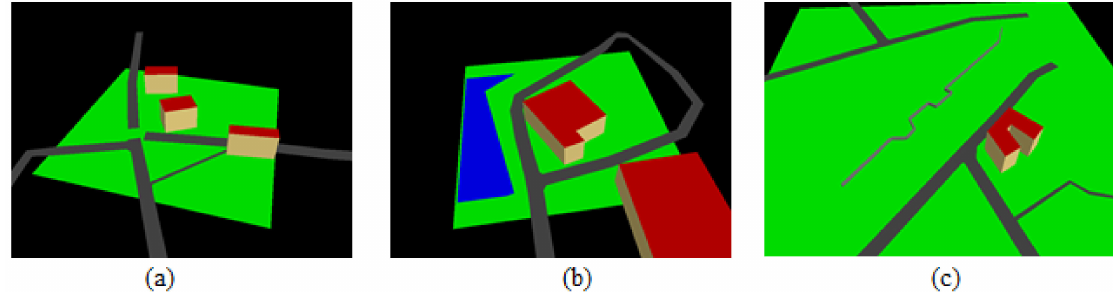
Figure 4. ( a ) Glass Mosque; ( b ) Saint Rocco temple; ( c ) Byzantine